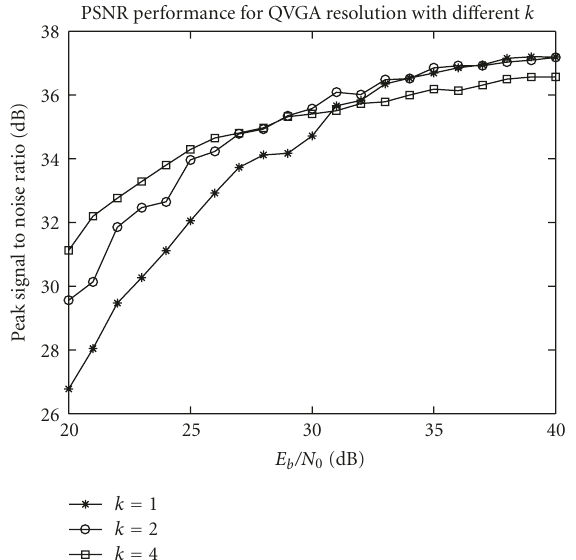
Figure 18: The overall PSNR performance for both VGA and QVGA resolutions with di ff erent space ratio k . The priority of each packet is labeled by and aware of by the MAC layer.